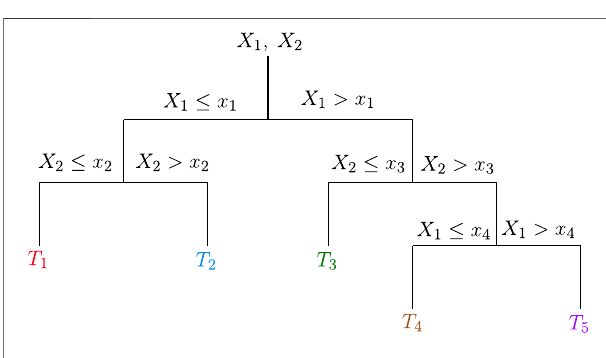
FIGURE 6 | An indicative example of a decision